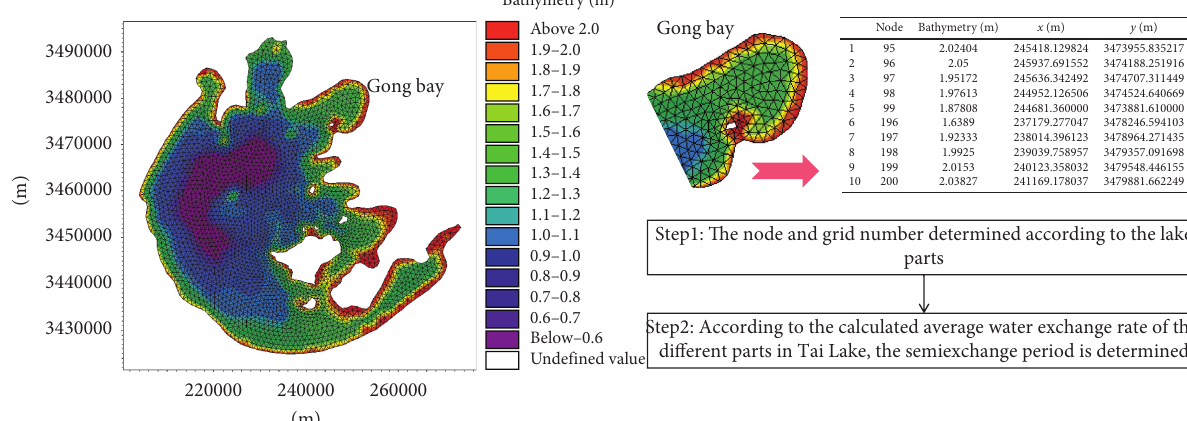
Figure 3: Two-step approach used to calculate the semiexchange period of Tai Lake using bathymetry